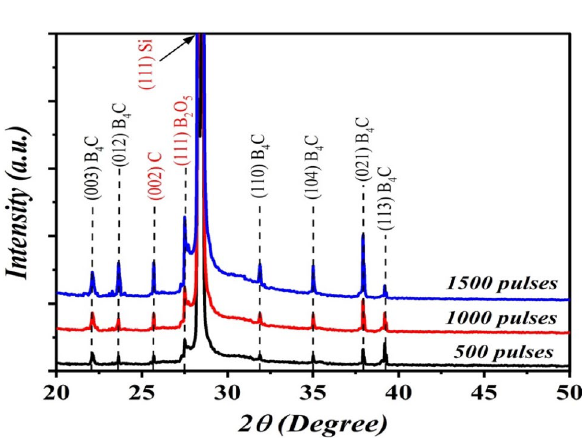
Figure 3. XRD patterns of B 4 C NPs prepared at various number of laser